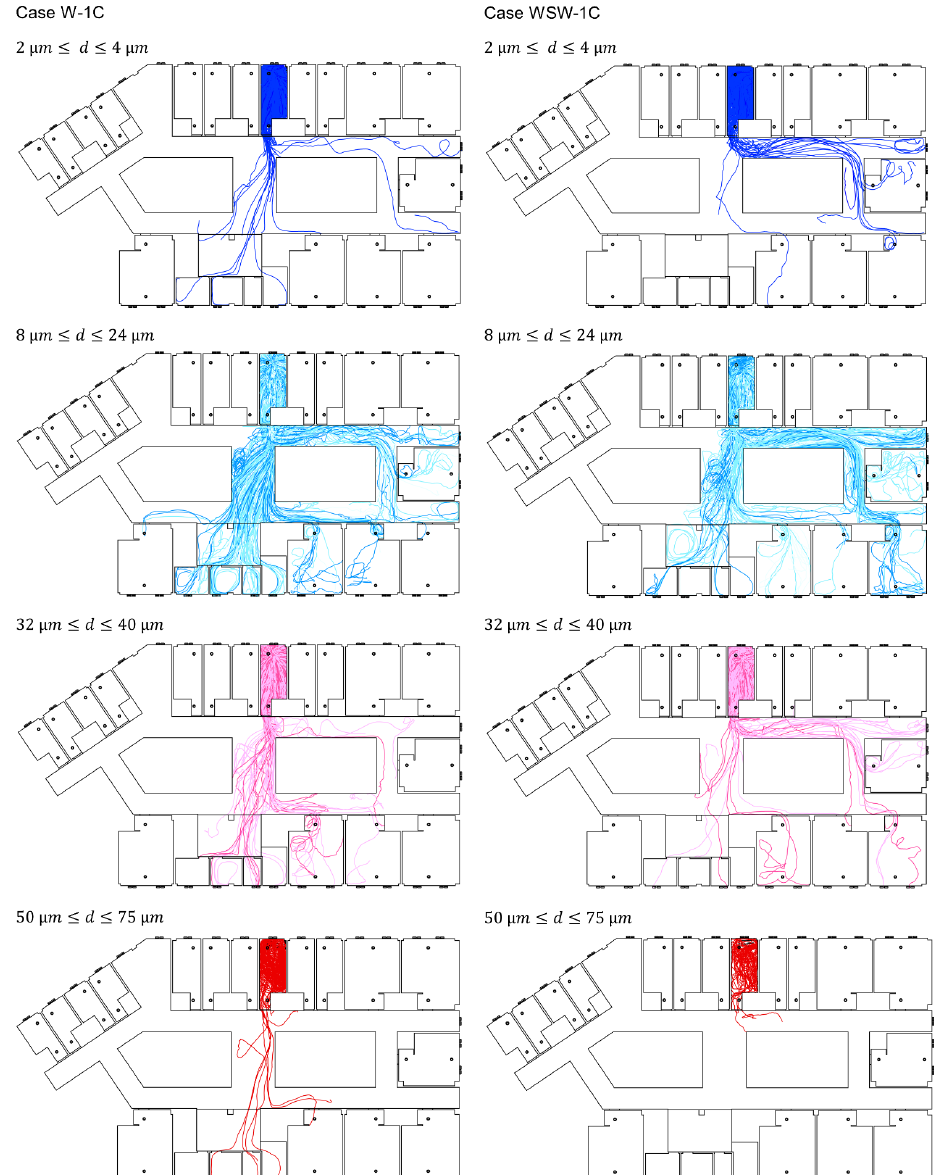
Figure 6. Trajectories of cough particles.